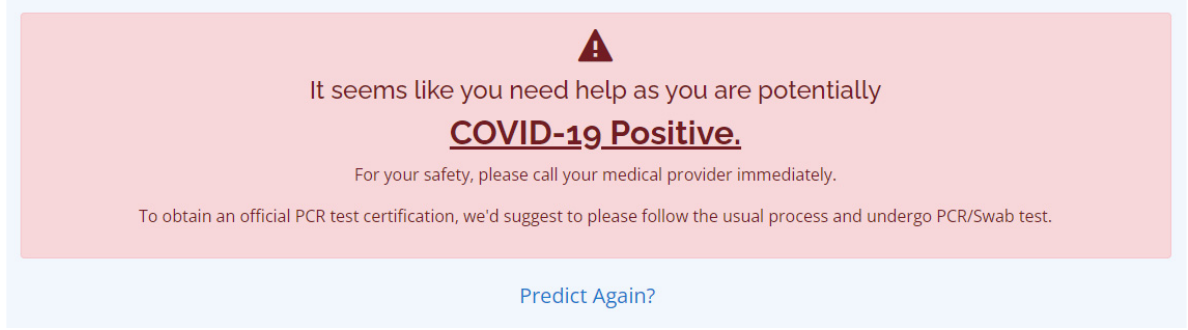
Figure 13. The notification for the COVID-19 Positive result.